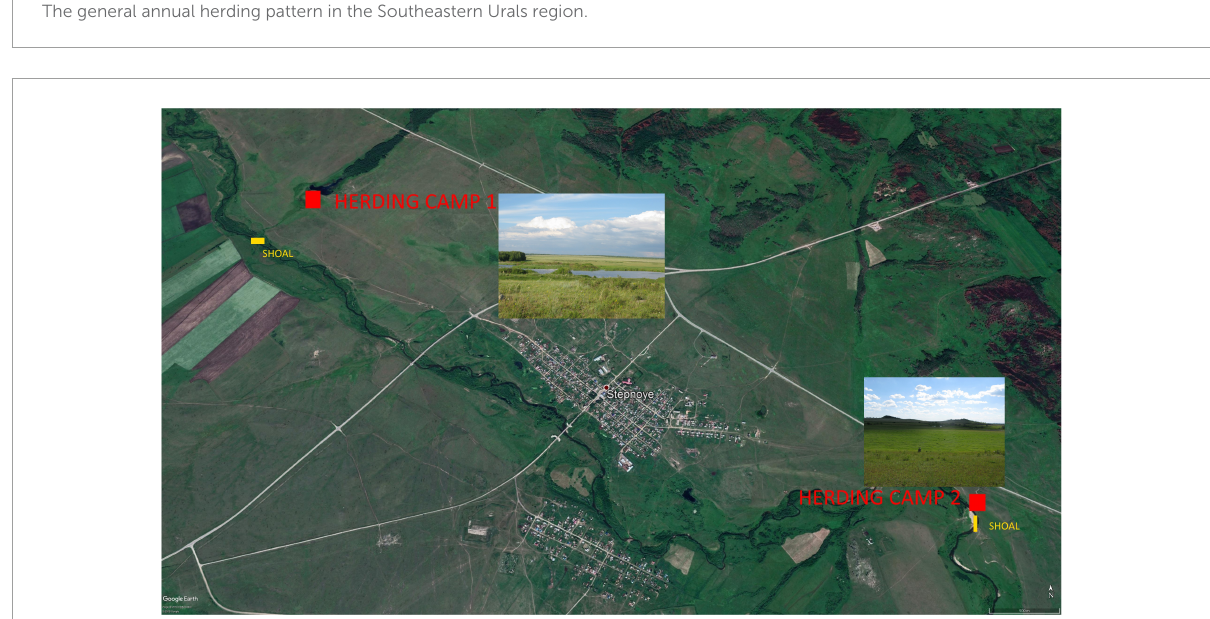
FIGURE5 Location and photos of the herding camps near the modern Stepnoye